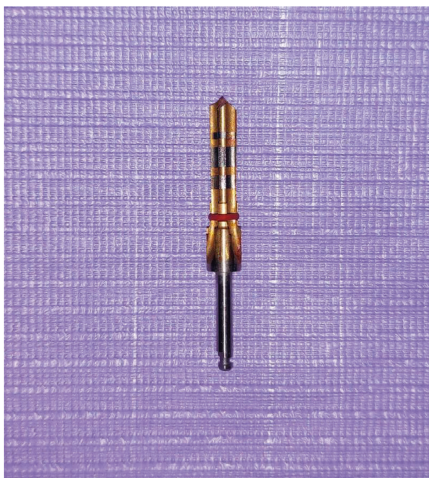
Figure 1: Single drill for preparing the final implant bed for 4.25Ø mm implant; the single drill design contains 3 straight flutes with wide channels between them (FGM, Arcsys).